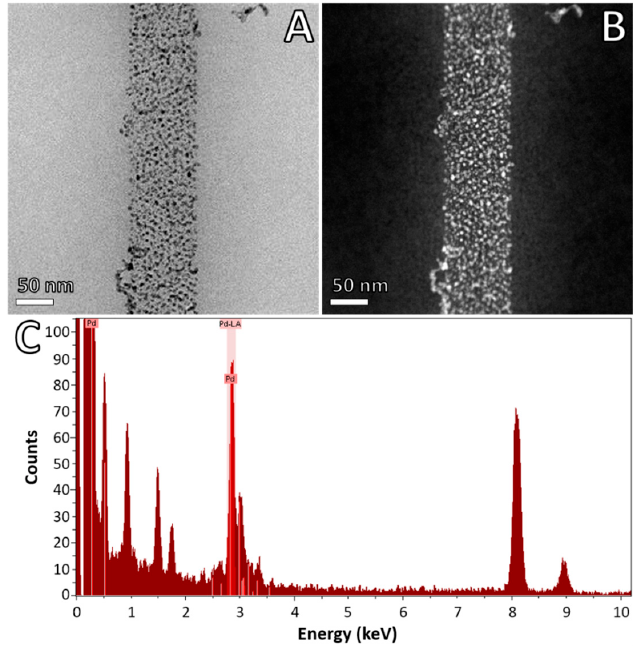
Figure 3. Atomic resolution Cs-STEM imaging. ( A ) BF-STEM imaging. ( B ) HAADF-STEM imaging. ( C ) EDX spectra. Imaging with JEM ARM-200F (JEOL), operated at accelerating voltage of 80 kV in STEM mode.